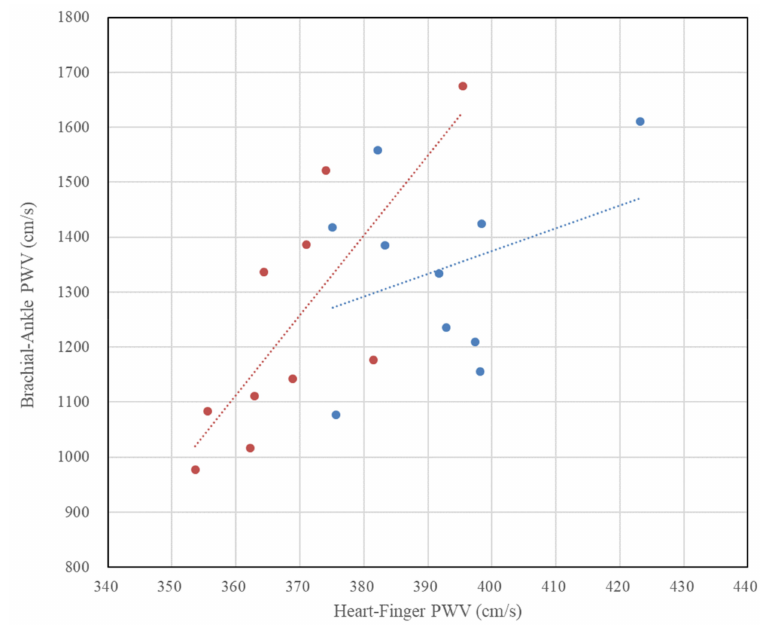
Figure 8. Relationship between brachial–ankle pulse wave velocity and heart–finger pulse wave velocity (blue: males, r = 0.34, p = 0.336, red: females, r = 0.79, p = 0.006).